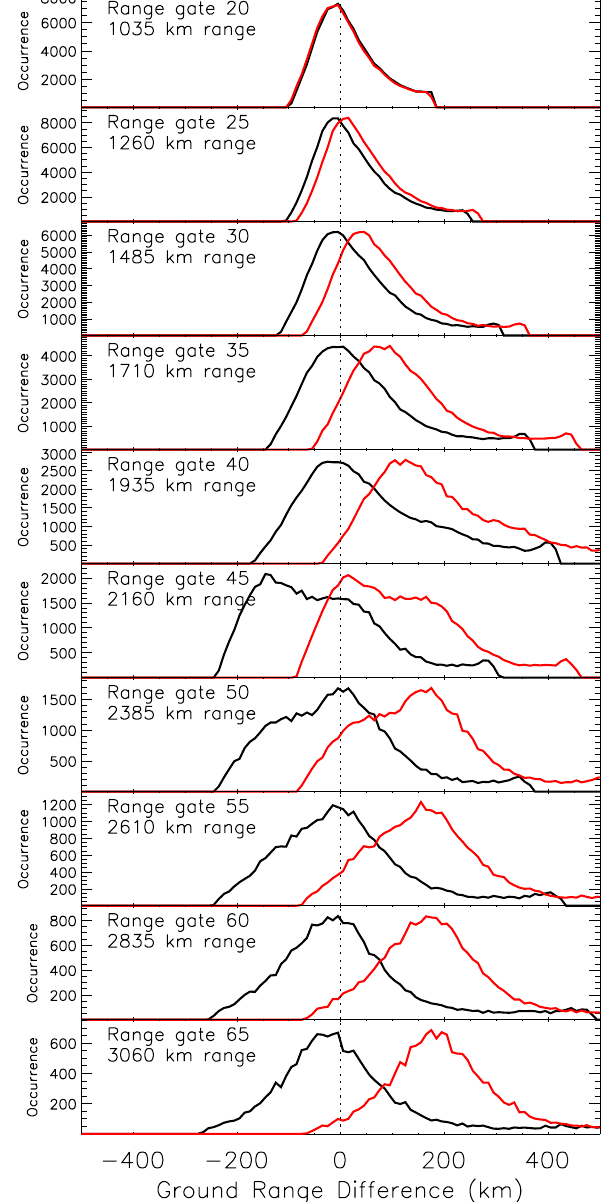
Fig. 14. Ground range difference distributions comparing the per- formance of the new empirical model (black distributions) and the standard SuperDARN model (red distributions) at a sample of sin- gle range gates. The distributions are determined by comparing all the ground range values measured at the specific range gate in the Saskatoon beam 3 data set with the ground range values predicted by the models. The ten panels show distributions every 5 range gates ranging from range gate 20 (1035km range; top panel) to range gate 65 (3060km range; bottom